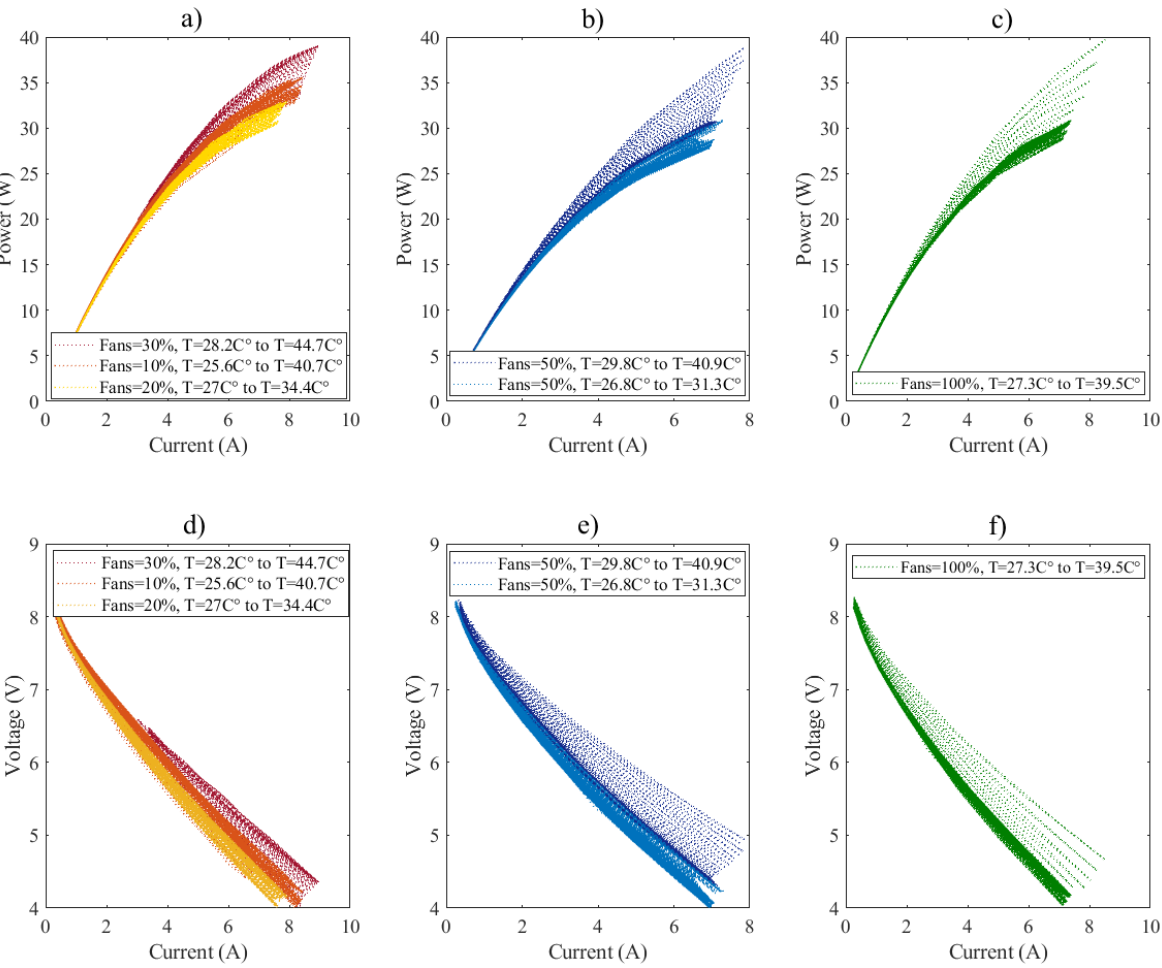
Figure 5. I stack - P stack and I stack - V stack measured data of Heliocentris FC50 fuel cell; ( a , d ): polarisation curves when Fans Power = [10%, 20%, 30%] and for different operating temperature; ( b , e ): polarisation curves when Fans Power = 50% and for different operating temperature; ( c , f ): polarisation curves when Fans Power = 100% and for different operating